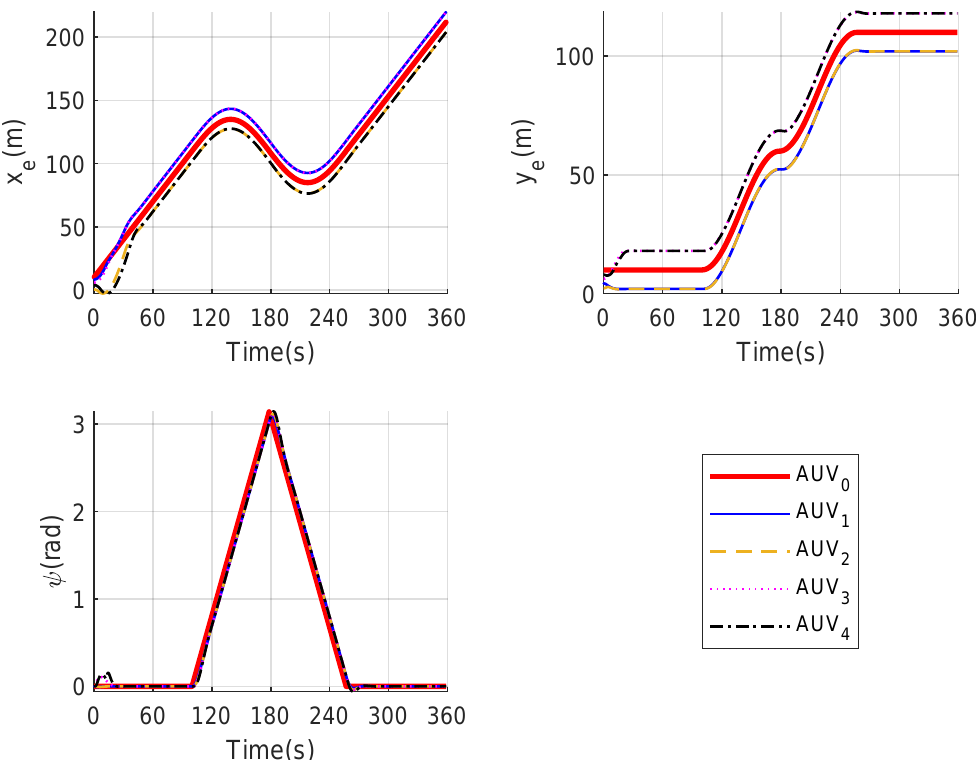
Figure 11. Position states of multi-AUV under alterable communication topology without delay.